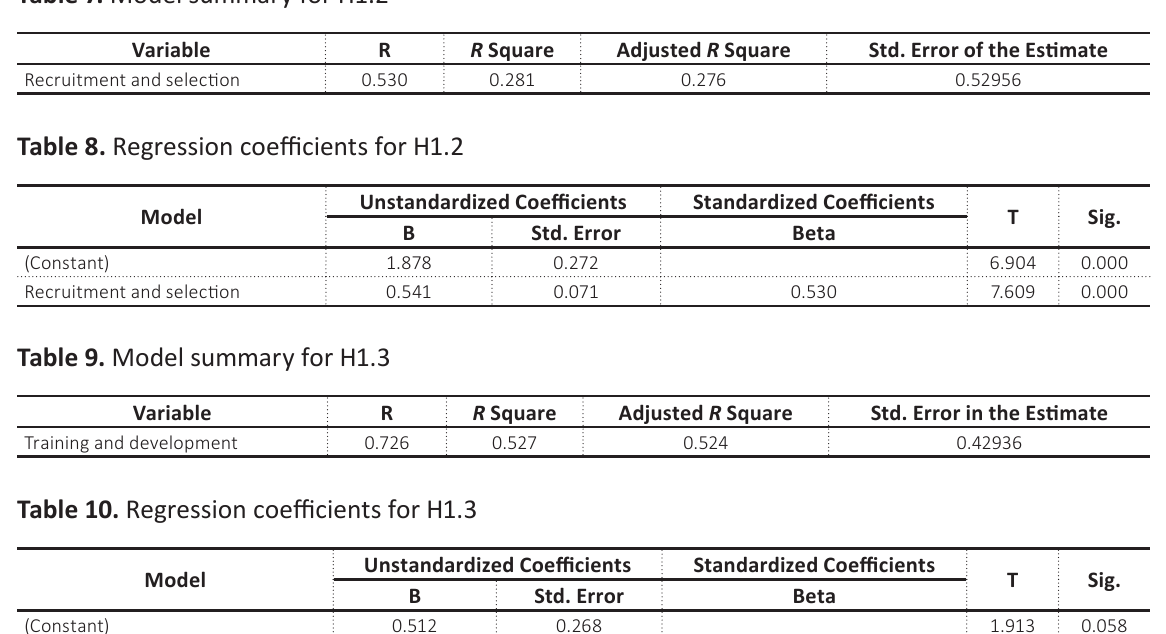
Table 7. Model summary for H1.2